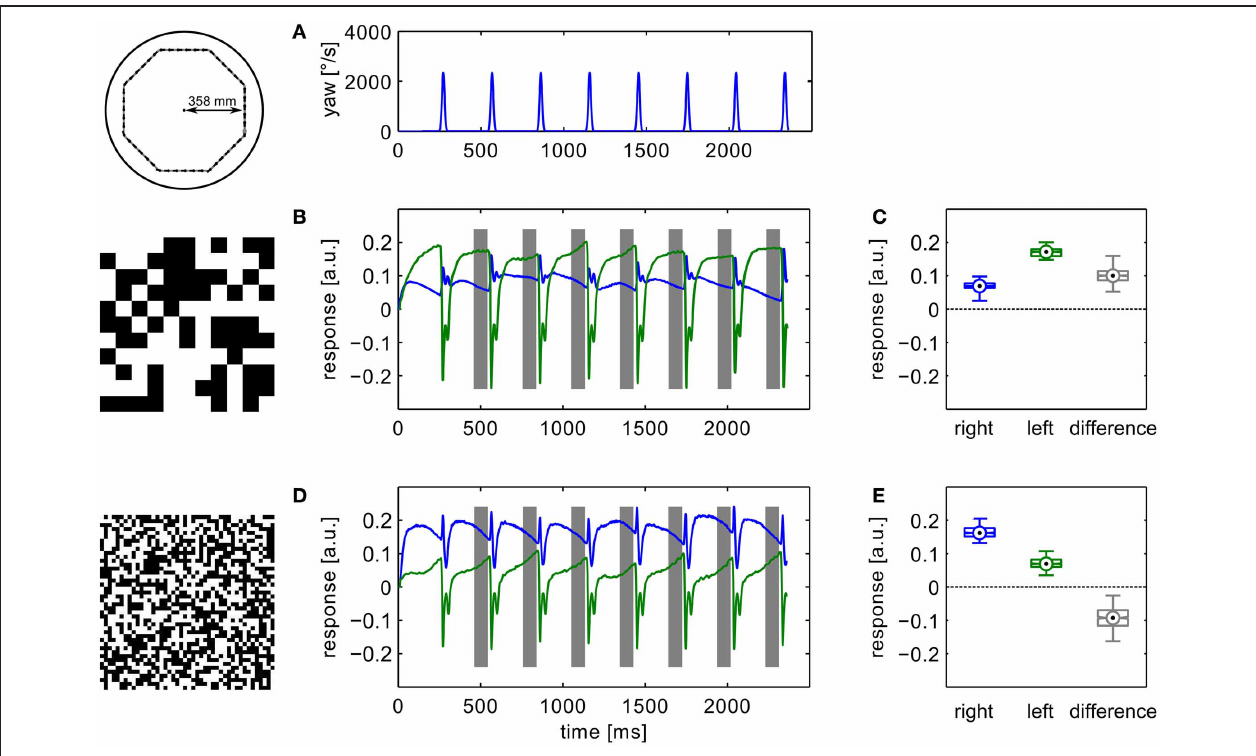
FIGURE 3 | Model responses. Responses to the sensory open-loop stimuli generated on the flight trajectories shown in Figure 1 obtained in flight arenas covered with two different textures. Top panel (A) shows the yaw velocity versus time; it is characterized by regular saccadic turns interrupted by straight flight segments. Responses of the sensory module of CyberFly to open-loop stimulus shown in (B,C) , Figure 2 . Response of the right input